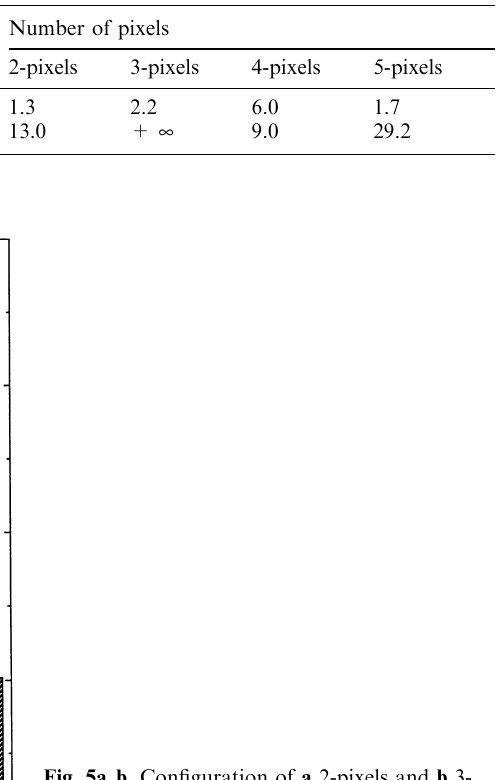
Fig. 5a,b. Configuration of a 2-pixels and b 3- pixels obtained in the case of actual data (pre- ICE’89)